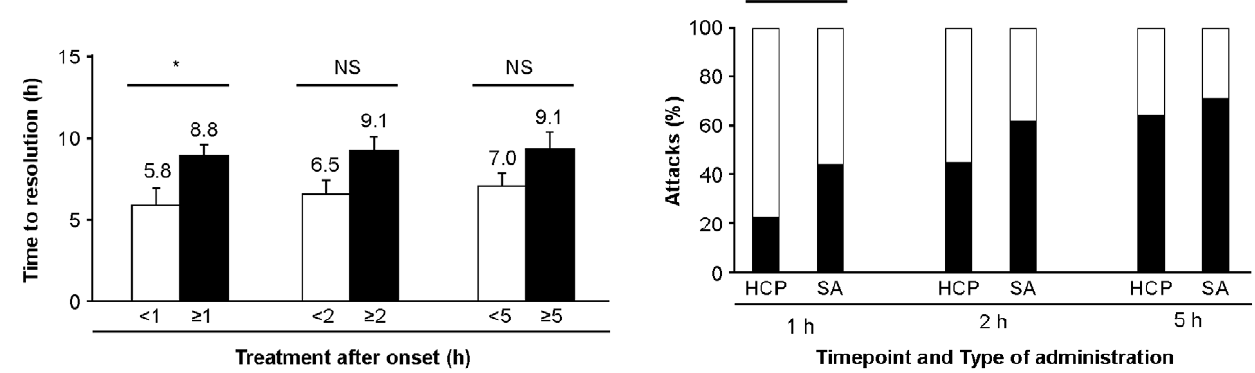
Figure 3. Very early treatment with icatibant reduced mean time to resolution. Figure demonstrates the mean time to resolution (time between first injection and complete resolu- tion of symptoms) of attacks treated before and after each timepoint. n=207 attacks ( , 1 hour, n=80; $ 1 hour, n=127; , 2 hours, n=120; $ 2 hours, n=87; , 5 hours, n=145; $ 5 hours, n=62); all attacks are included at each timepoint; * p =0.033, NS, not significant.